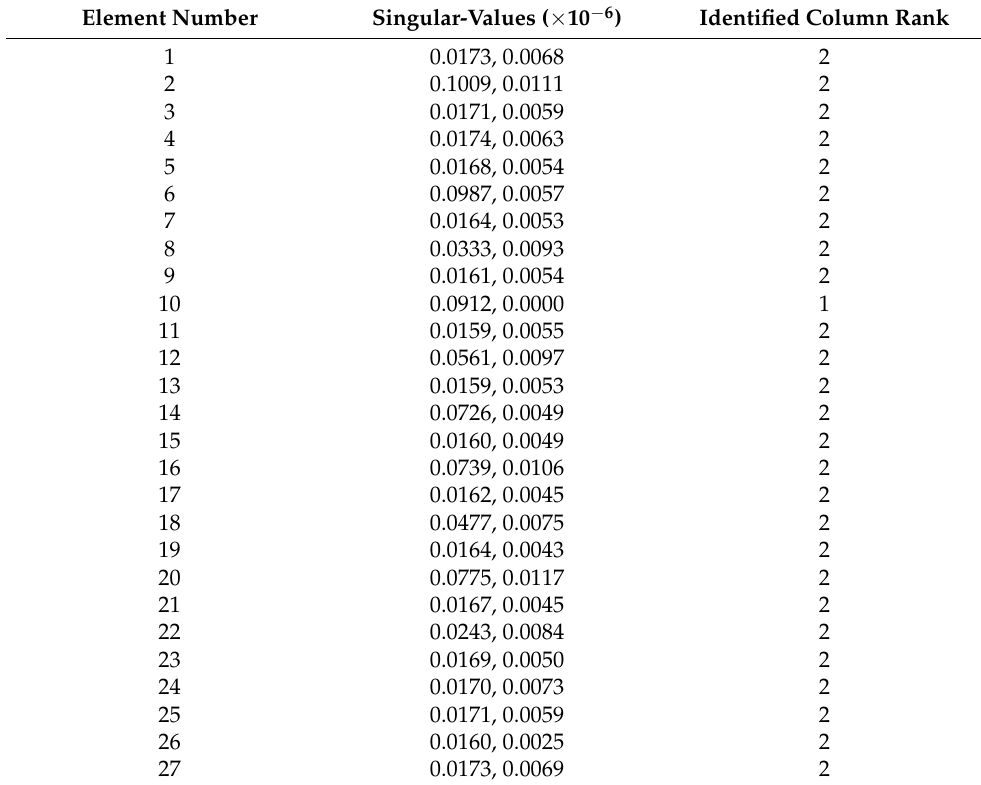
Table 2. The singular-values of the flexibility correlation matrix for each element. Element